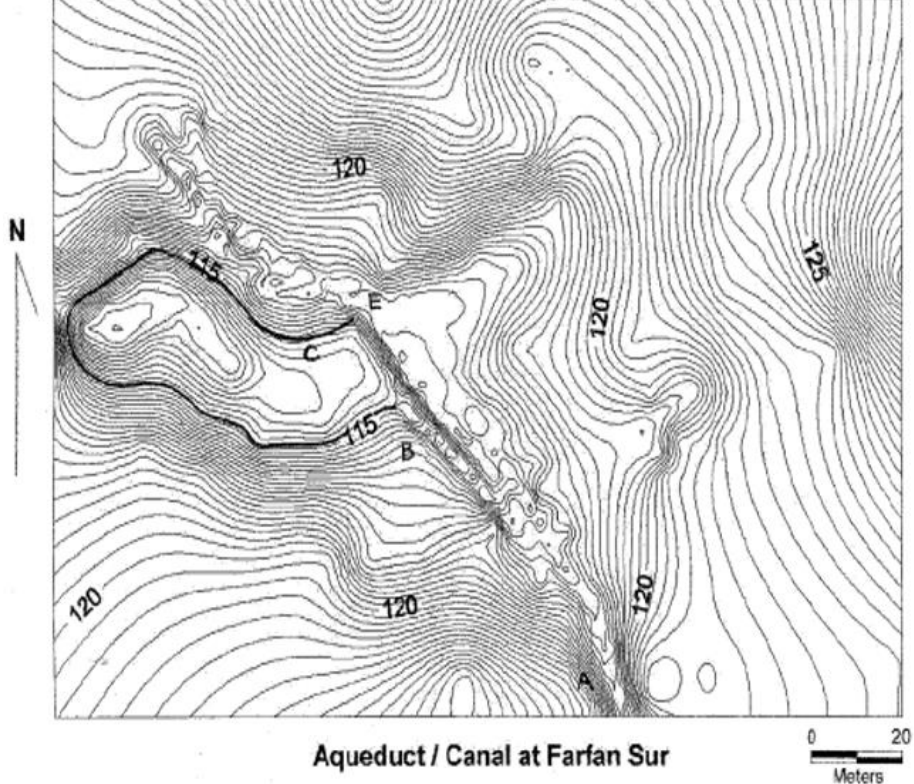
Figure 11. Low slope channel path from Figure 10, D channel wall opening to an intersection loca- tion midway on the steep decline canal path to the low aqueduct. Figure from [1], pp.